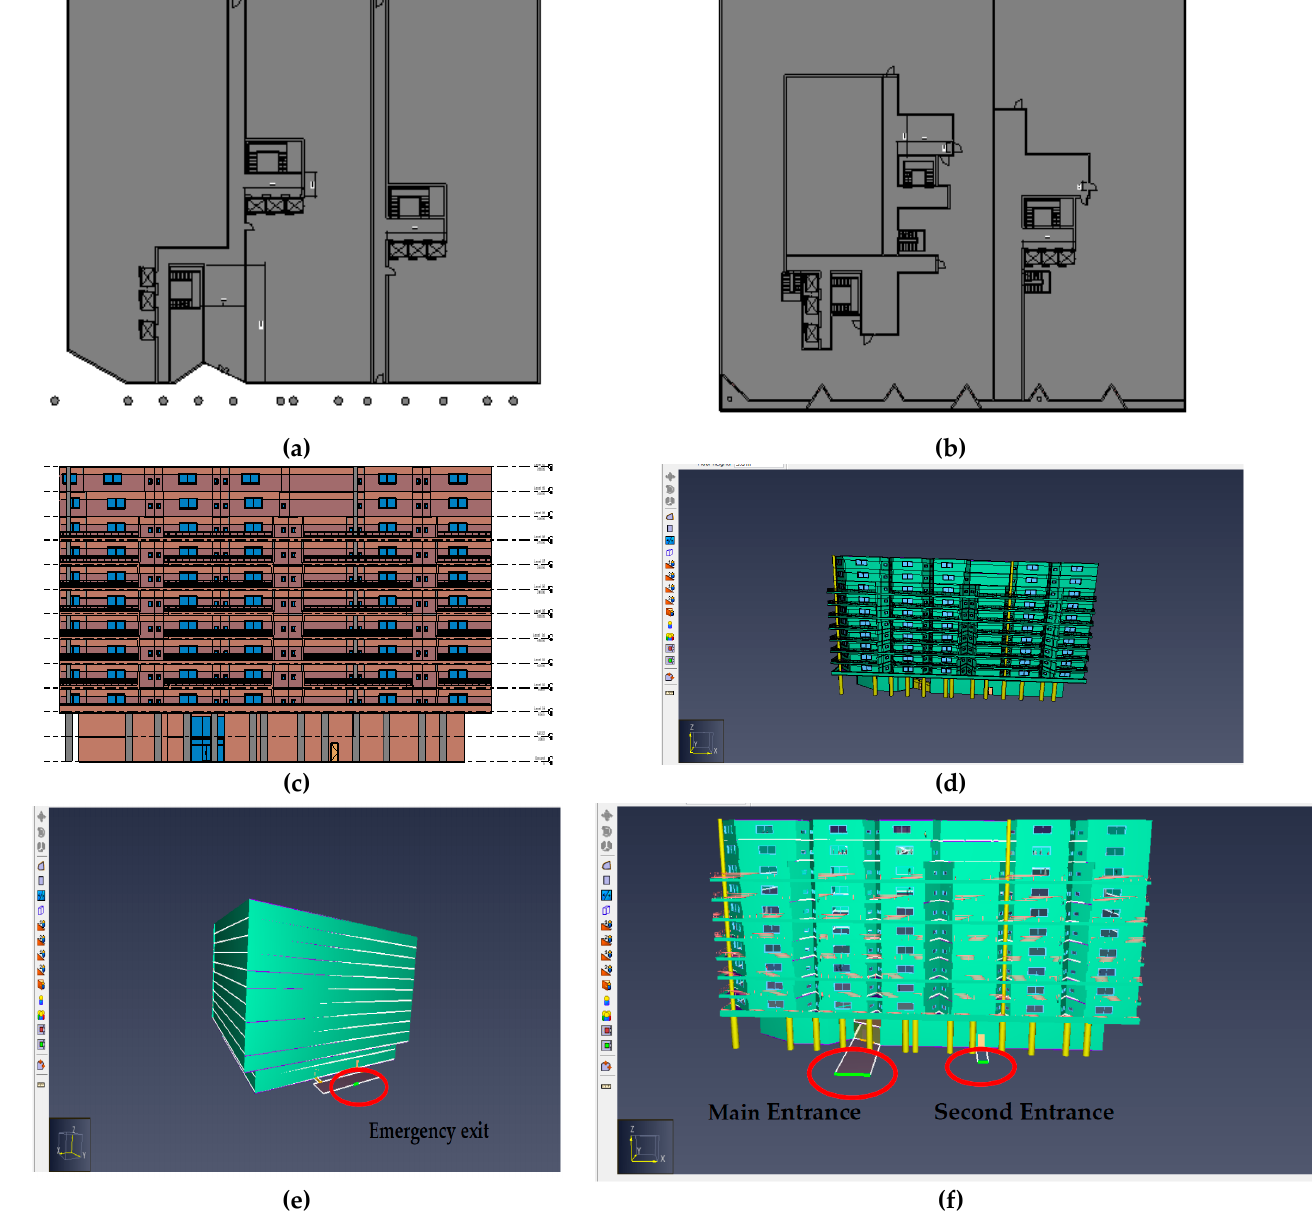
Figure 1. Building models: ( a ) ground floor plan, ( b ) plan of upper floors, ( c ) 3D Revit model, ( d ) 3D Pathfinder model, ( e ) emergency exit, ( f ) main entrance and second entrance.